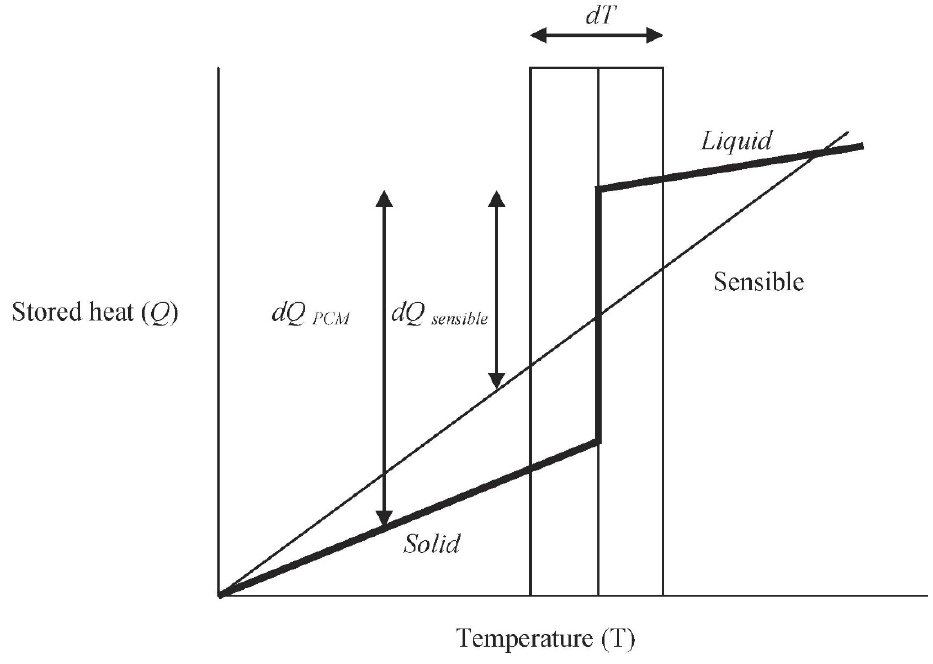
Figure 4. Behavior of PCM under varying temperature [37] (Copyright from Elsevier, Licensed number 5147210406326).